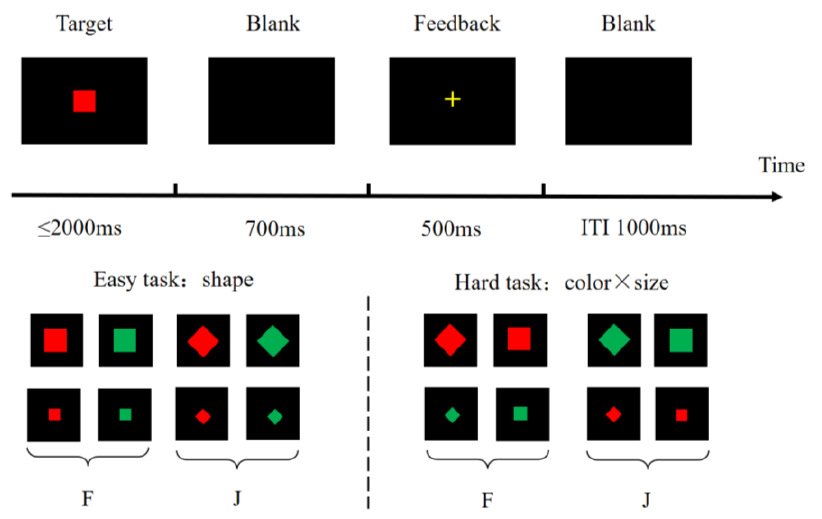
Figure 1. Above : Schematic time‑course of the metacontrol paradigm. Below : Target stimuli for the easy and hard